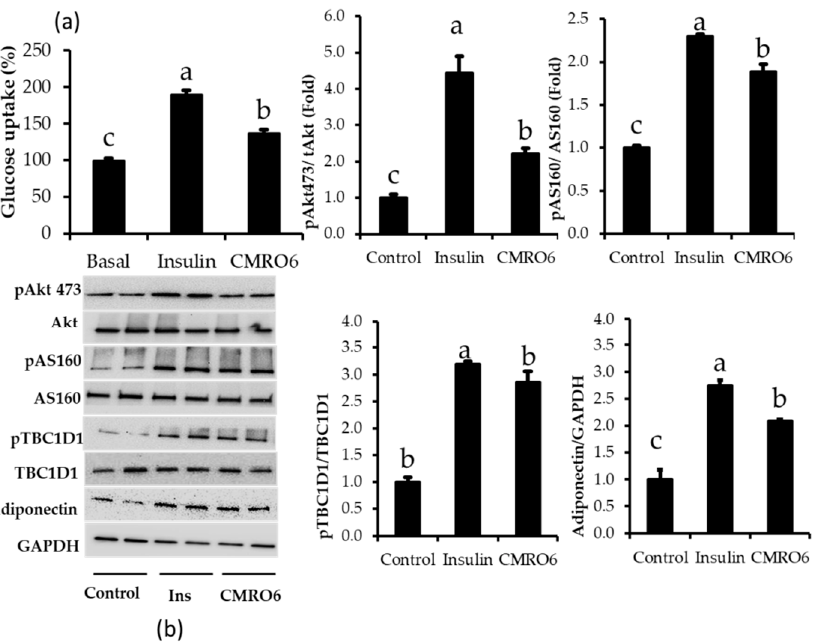
Figure 5. Effect of CMRO6 on glucose uptake and insulin-related signaling pathways. ( a ) Glucose uptake was measured in differentiated adipocytes with a Promega glucose uptake-Glo assay kit. ( b ) Phosphorylation levels of insulin-stimulated signaling pathways (Akt, AS160, and TBC1D1) and adiponectin expression, which is related to glucose uptake, in response to insulin and CMRO6 treatment. Results are presented as the mean ± STD of three replicates. Different letters within the figure indicate significant differences ( p < 0.05).